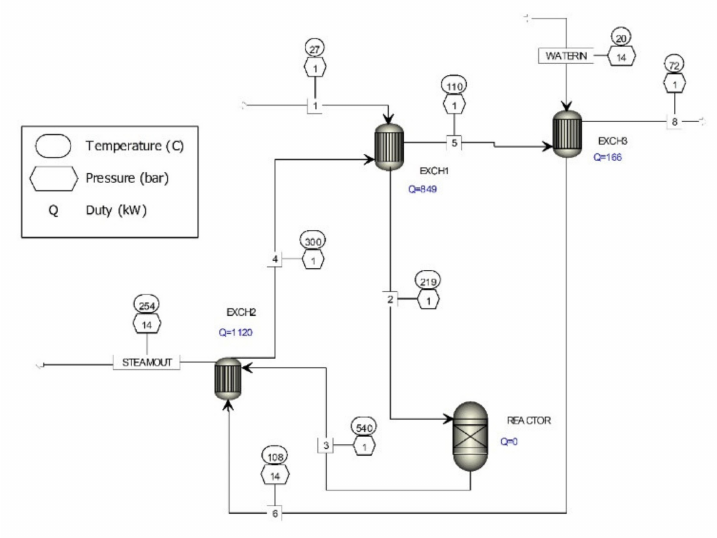
Figure 1. Computer simulation of waste gas treatment process of metal oxide catalyst formaldehyde